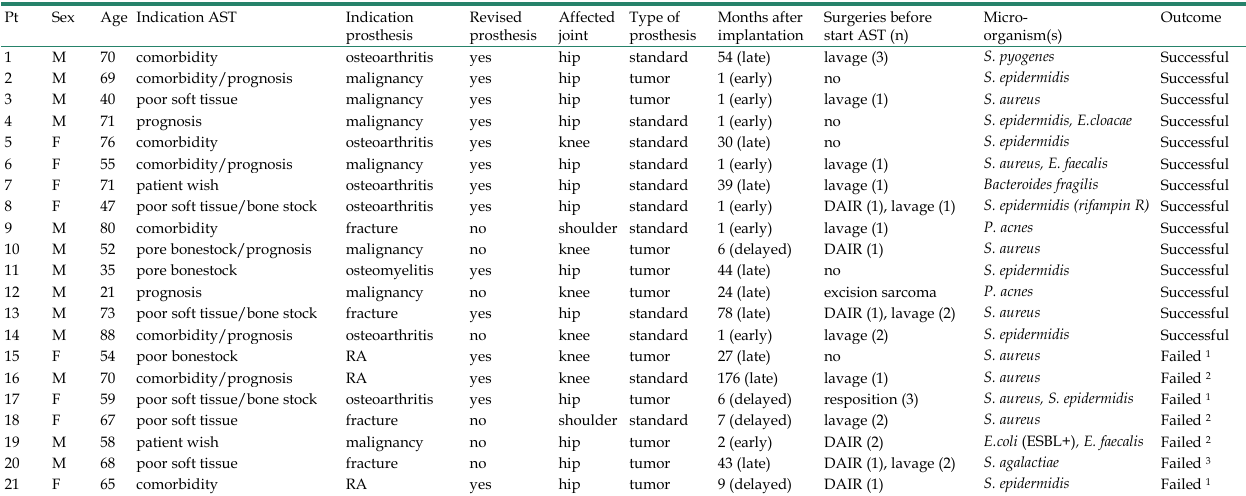
Table 1 . Overview of patient characteristics and outcome of antibiotic suppressive therapy